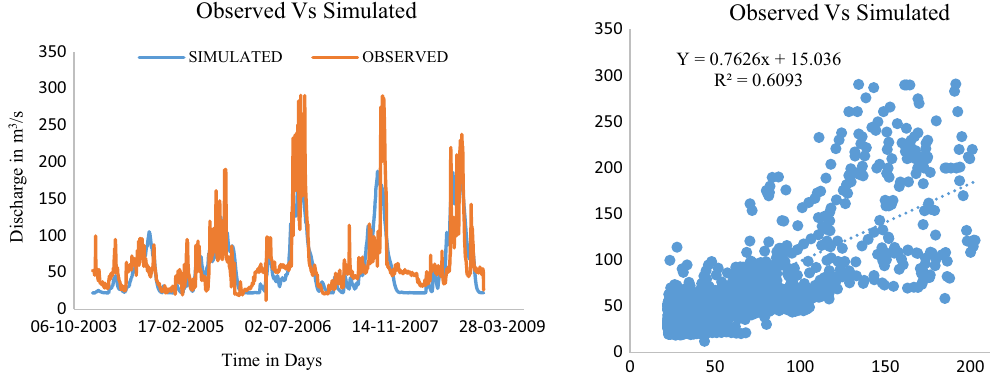
Fig. 5 Simulated versus observed flow data for SCS CN after calibration Table 15 Calibration for green and Ampt loss method result